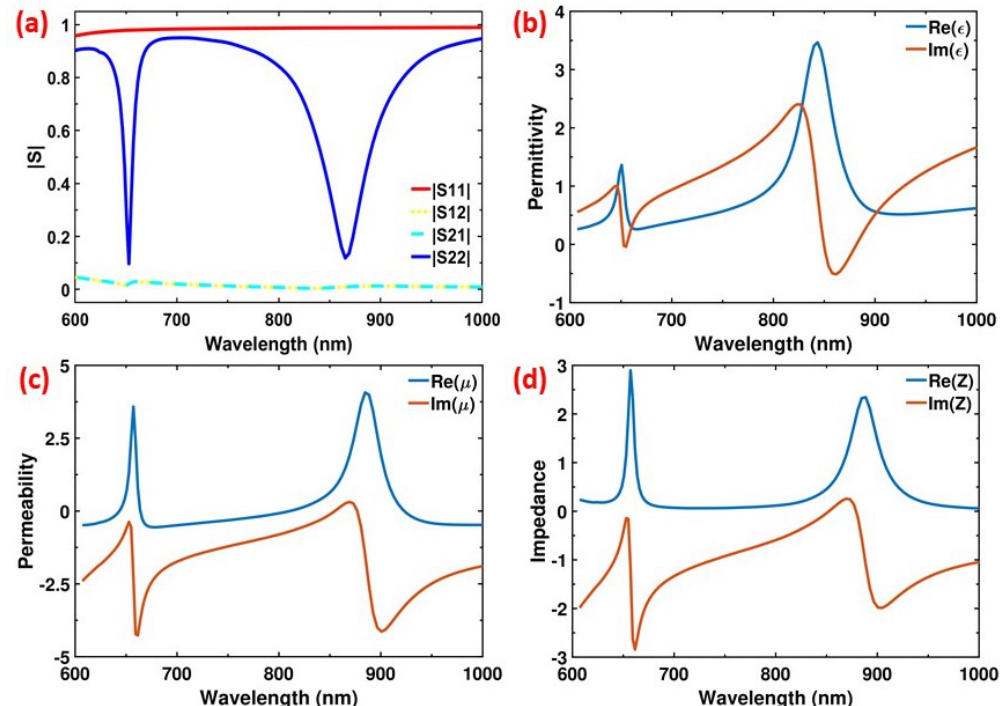
Figure 5. ( a ) Magnitude of the simulated complex S-parameters of the proposed PA for both forward and backward propagating source directions. Effective optical parameters, permittivity ( b ), permeability ( c ), and impedance ( d ) are extracted from the S-parameters as functions of the wavelength. At both resonant wavelengths, the real part of the effective impedance of the proposed PA satisfies the impedance matching condition Re ( Z 1 ) ≈ Re ( Z 2 ) ≈ Z air/vacuum ≈